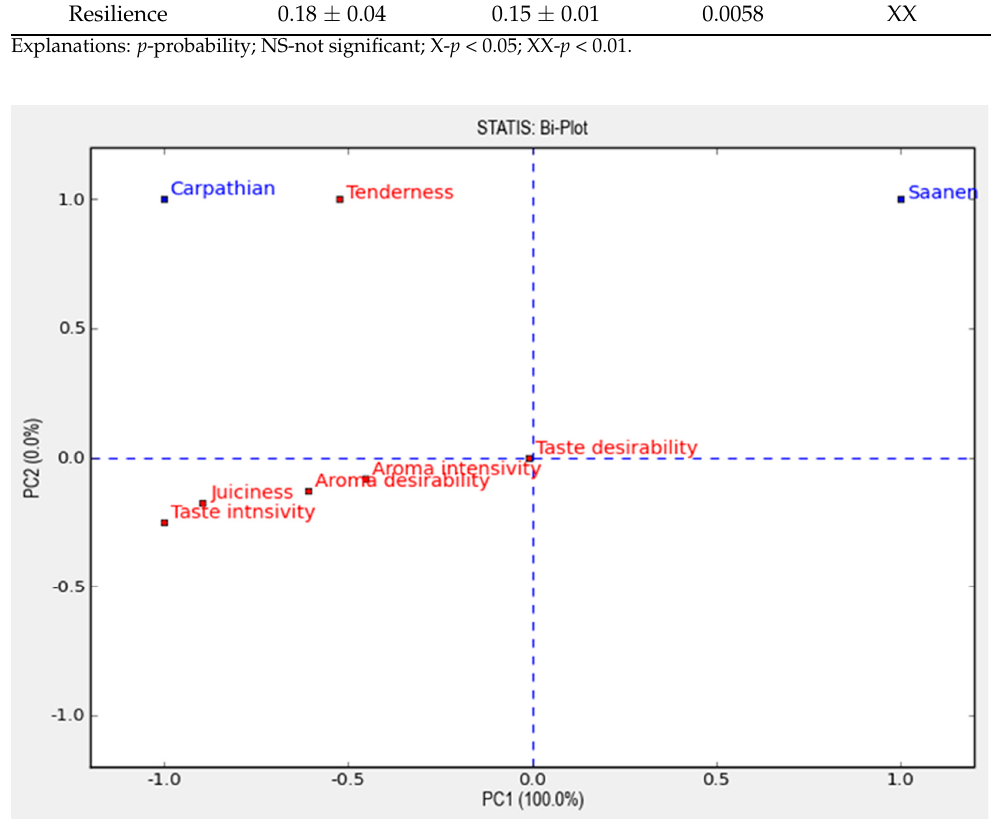
Figure 1. Biplot.